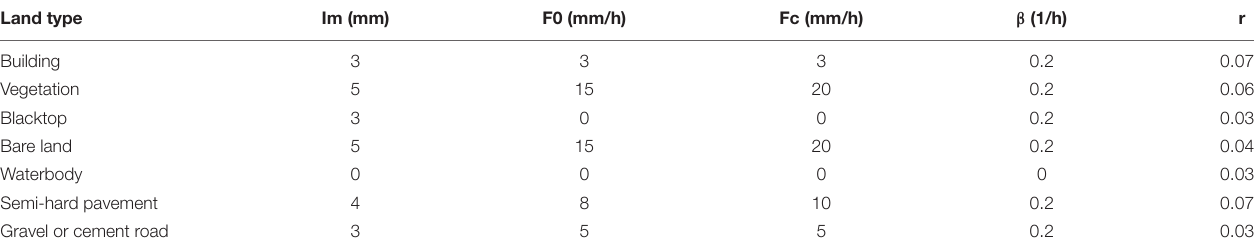
TABLE 1 | The basic infiltration parameters for runoff in Beijing city. Land